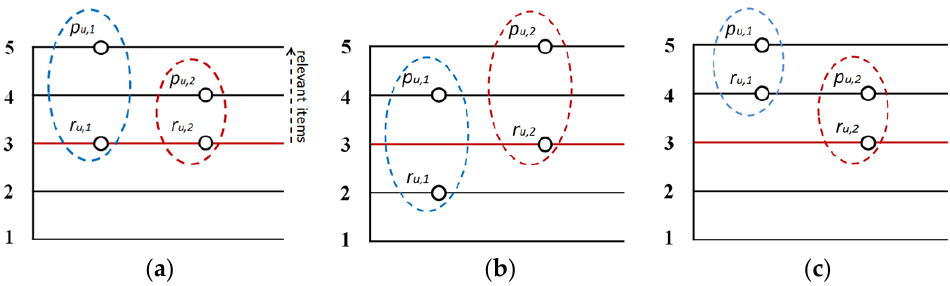
Figure 2. The description of predictive accuracy and classification accuracy using example items. ( a ) with the same classification accuracy, item 1 has worse predictive accuracy than item 2; ( b ) with the same predictive accuracy, item 1 has worse classification accuracy than item 2; ( c ) item 1 and item 2 have same results on both predictive accuracy and classification accuracy.